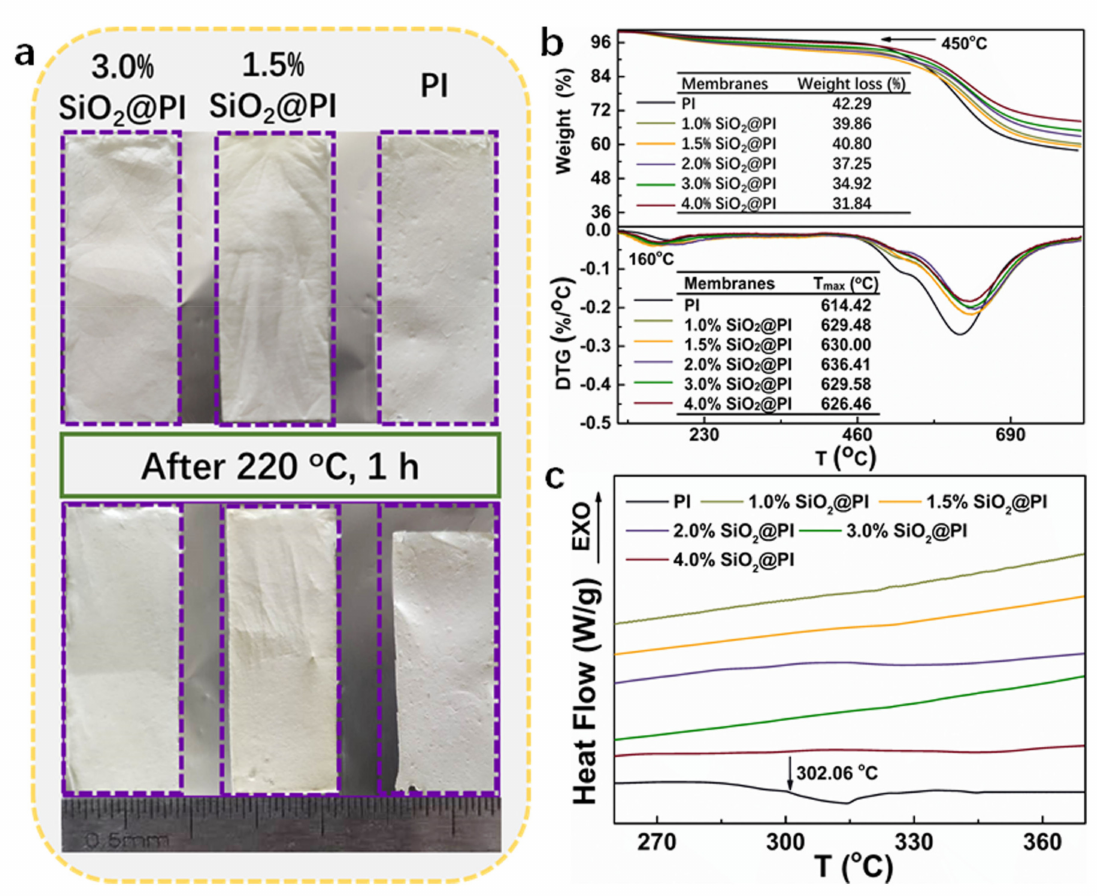
Figure 5. ( a ) Photos of PI and SiO 2 @PI nanofiber membranes before and after being exposed at 220 ◦ C for 1 h; TG and the di ff erential thermogravimetric (DTG) curve ( b ) and di ff erential scanning calorimeter (DSC) curves ( c ) of the electrospun hybrid membranes with di ff erent SiO 2 NP